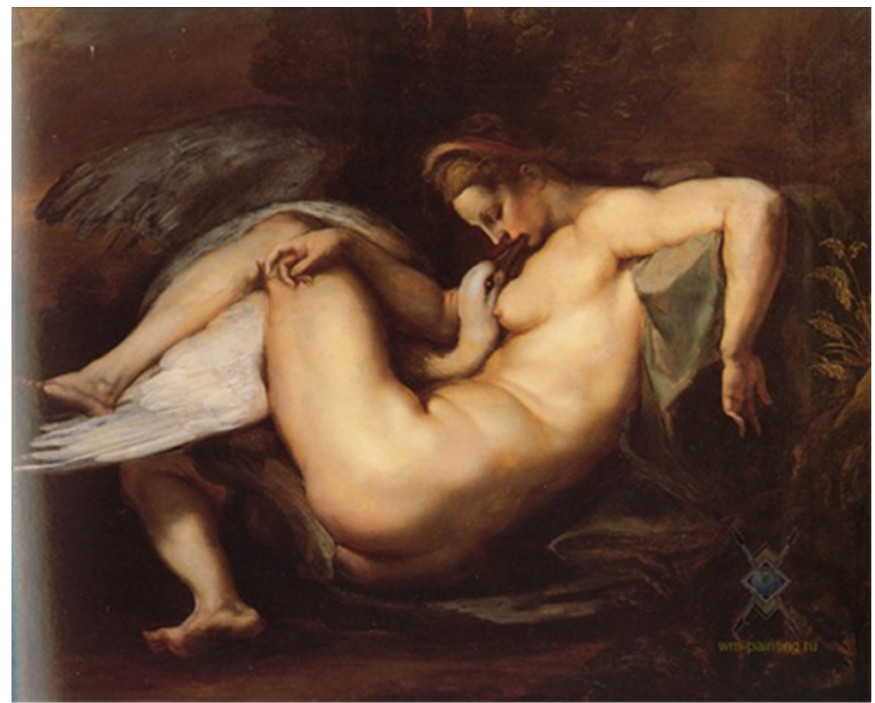
Figure 12. Peter Paul Rubens. “Leda with a Swan” (1600) after Michelangelo (circa 1530).